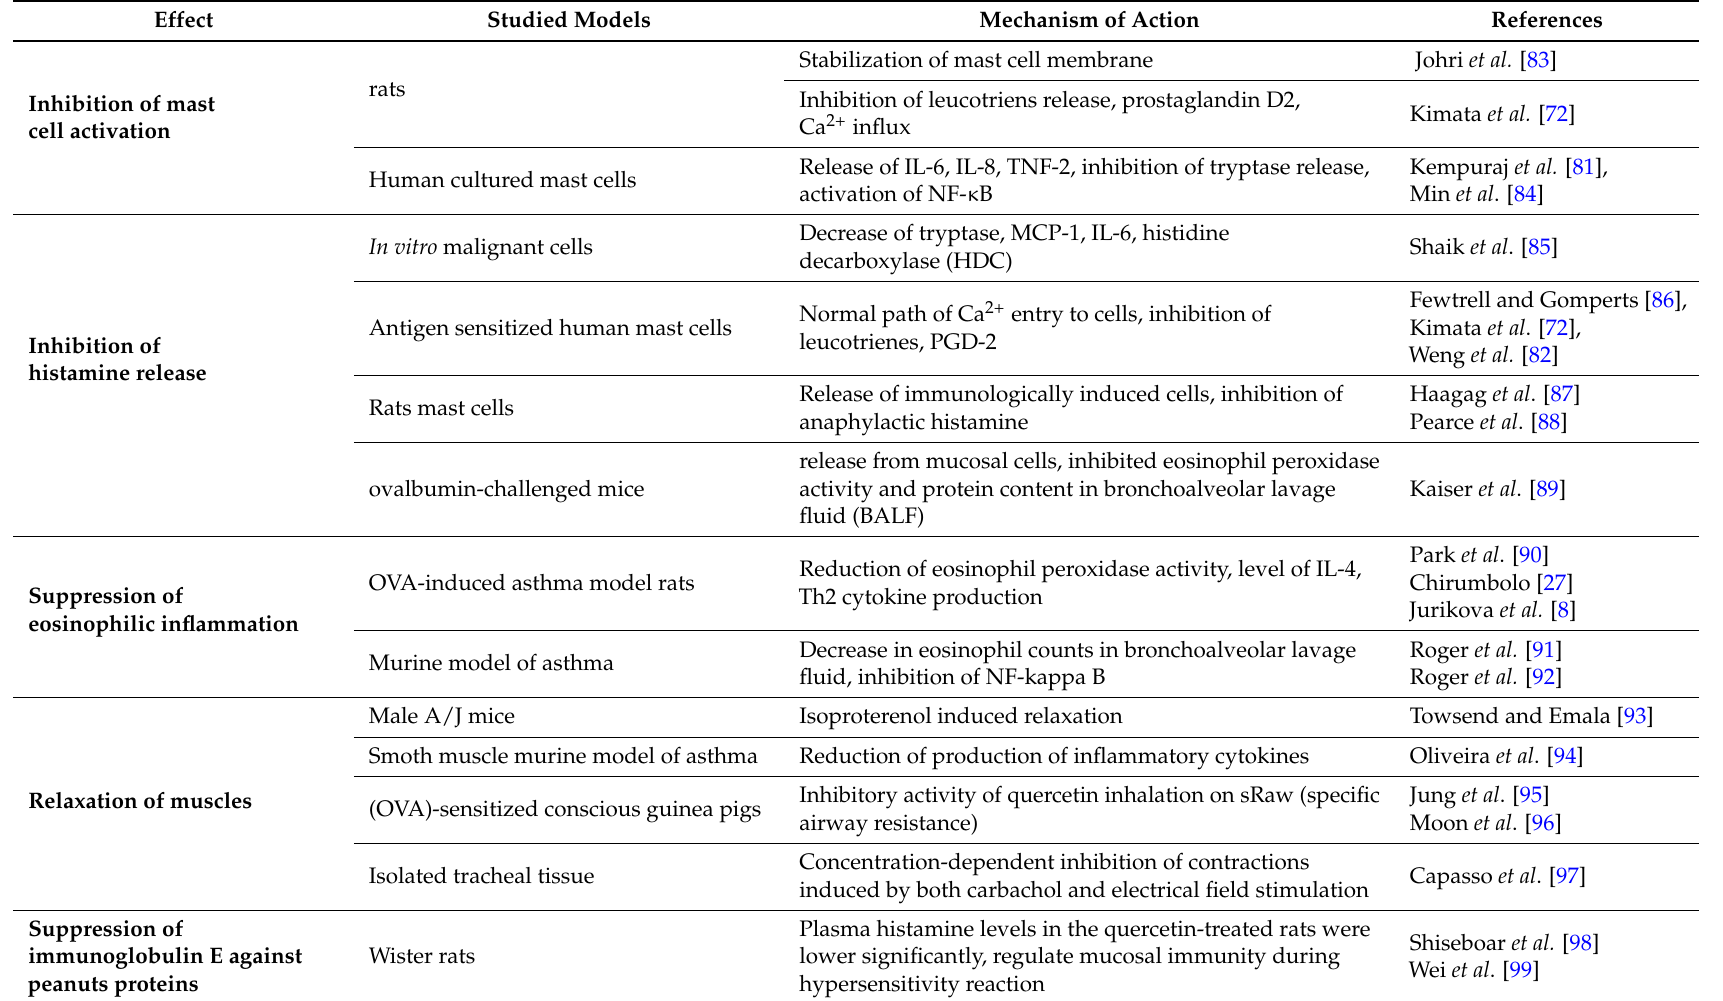
Table 1. Summarization of quercetin and its anti-allergic effect— in vitro